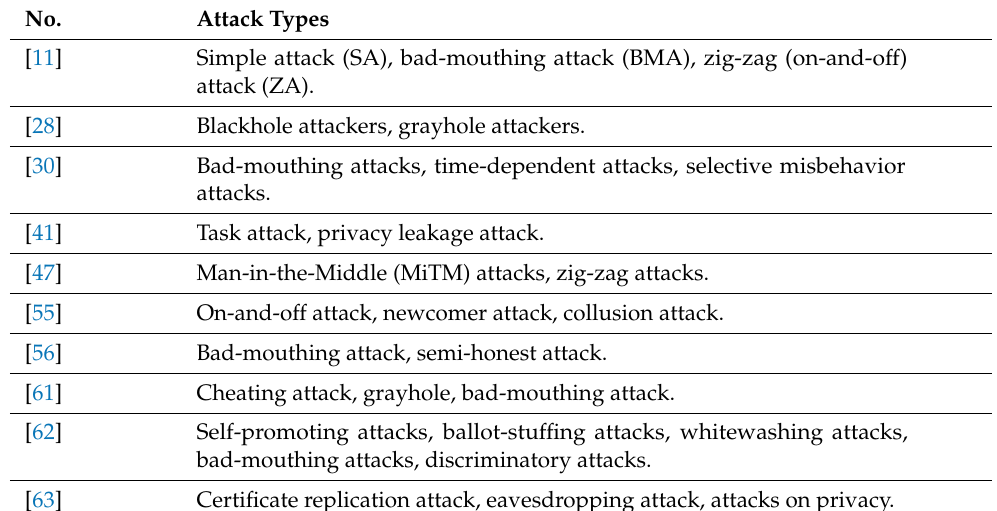
Table 5. Main existing